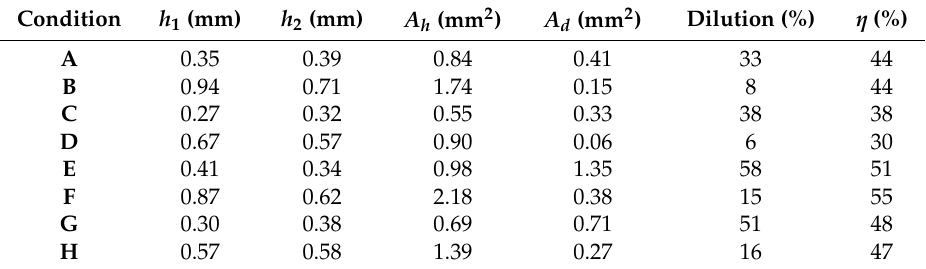
Table 10. Average geometrical responses in the cross section for deposition over edges.